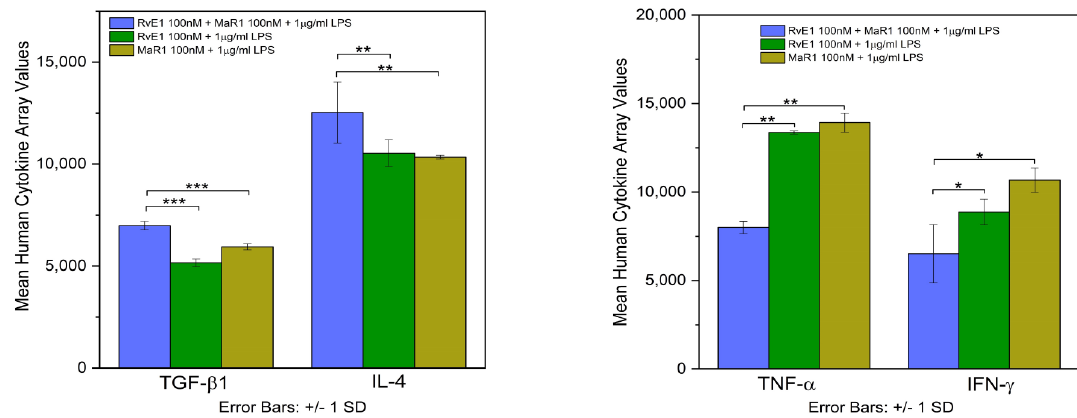
Figure 7. The left panel of the graphs show the expression of anti-inflammatory cytokines (IL-4 and TGF- β 1), and the right panel pro-inflammatory cytokines (IFN- γ and TNF- α ) by human cytokine array assessment in the three analyzed groups. The experiment was repeated three times ( n = 3). (*** p ≤ 0.001, ** p ≤ 0.01, * p ≤ 0.05).